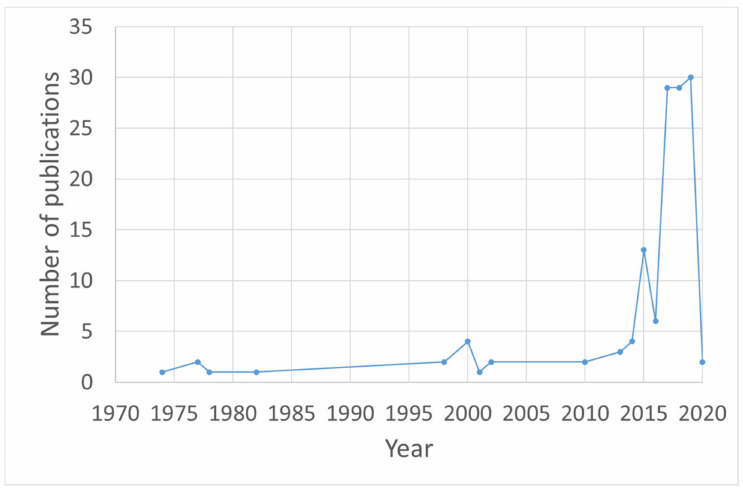
Figure 3. Number of publications per year in the period